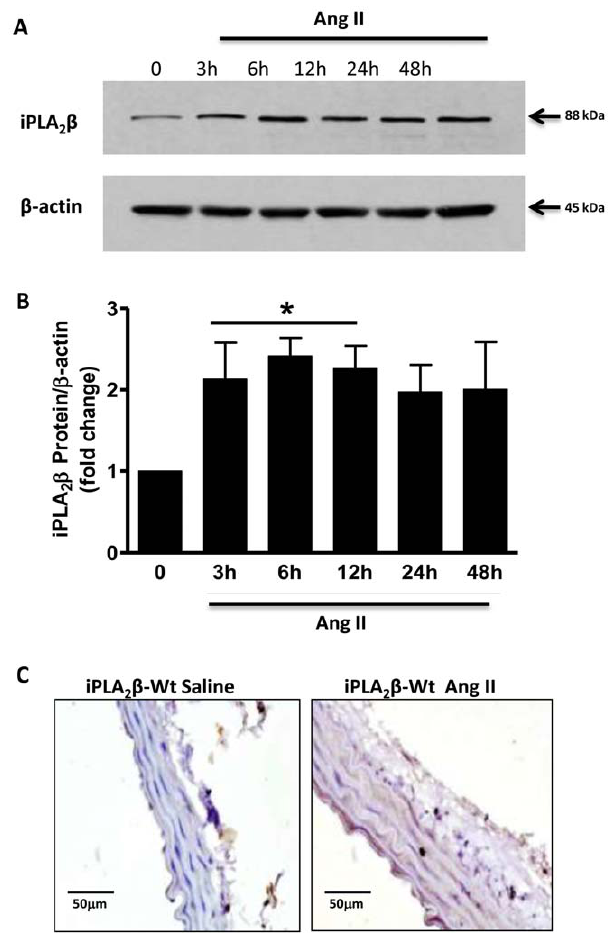
Figure 8. Ang II enhances iPLA 2 b protein expression in cultured VSMC and in-vivo . 24 h serum-deprived rat aortic VSMC were stimulated with Ang II (100 nM) for various time intervals as indicated. iPLA 2 b protein abundance was determined by Western Blot ( A and B ). Representative immunohistochemical images of iPLA 2 b protein staining in C57/B6 thoracic aorta from iPLA 2 b -Wt and iPLA 2 b -Tg mice infused with saline or Ang II (500 ng/kg/min, 14 days) ( C ). n=4–5; *: p , 0.05 by one-way ANOVA analysis.